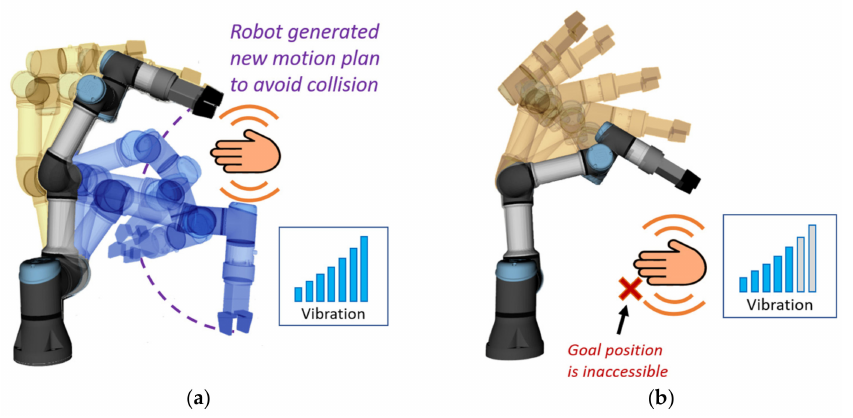
Figure 3. Status-related notifications: ( a ) replanning notification; ( b ) inaccessible goal notification. Vibration intensities were handpicked to make the haptic feedback unobtrusive when active. Vibration intensities for individual notifications are shown in Table 1, where the intensity of vibration is proportional to the provided PWM duty cycle represented in the range 0–100%: 0% represents no vibration, 100% represents the maximum attainable vibration. Preliminary tests have demonstrated that the vibration motors have high inertia and start spinning only at intensities above 30% PWM duty cycle. However, it was also noticed that for most users, only vibration above 50% of maximum intensity was noticeable. Table 1. Notification vibration